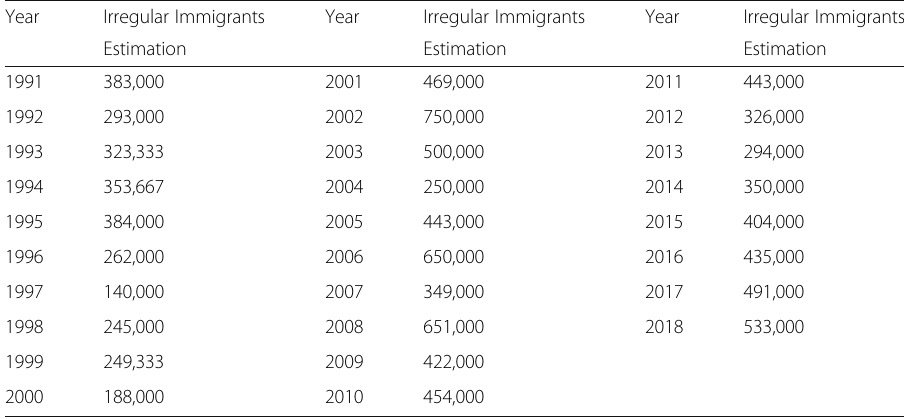
Table 1 Source ISMU Estimations of irregular immigrants in Italy, 1991 –